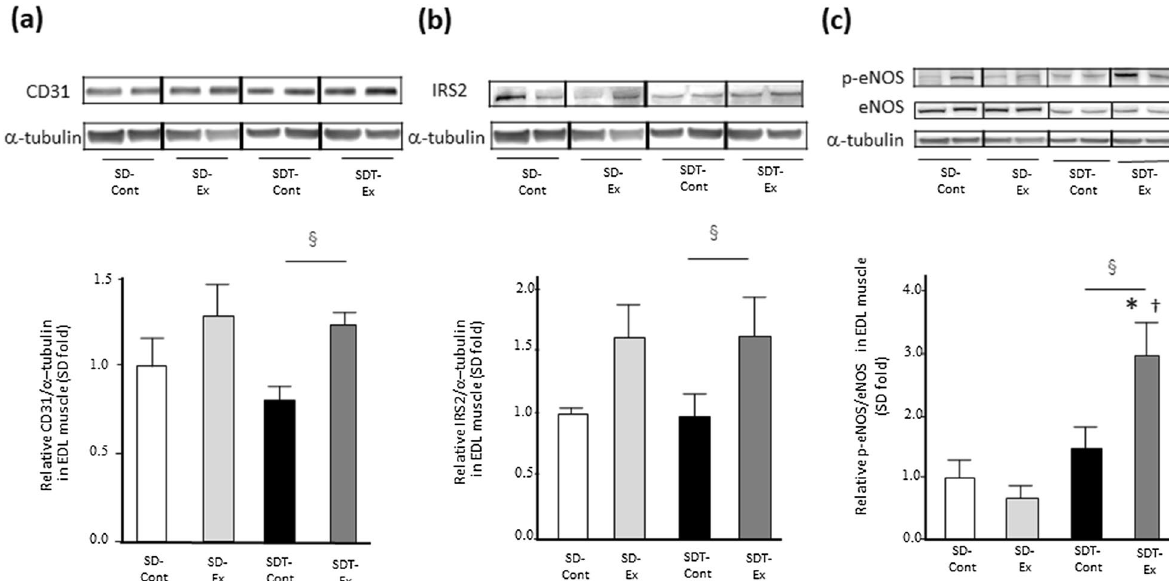
Fig. 7 Protein expression related to vascular endothelial cells in the extensor digitorum longus (EDL) muscle. Protein expression of CD31 ( a ), insulin receptor substrate 2 (IRS2) ( b ), and phosphorylated endothelial nitric oxide synthase (eNOS) (c) as determined by western blot analysis. Entire images of western blotting are shown in online Additional file 1: Fig. S9 (a, c, e) and S10 (a, c, e). Values are presented as mean the mean. SD‑Cont group, n